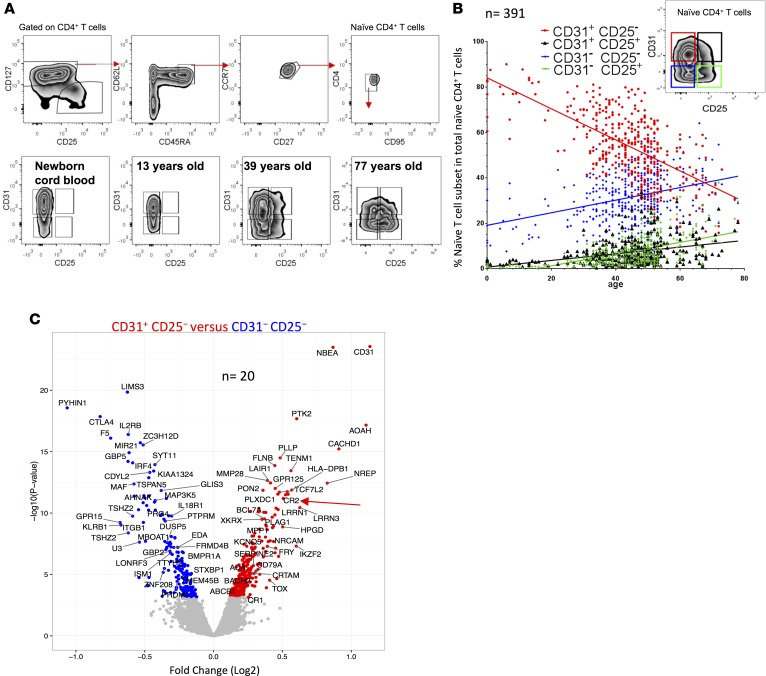
Gene expression profiling of 4 naive CD4+ T cell subsets identify age-related molecular signatures.(A) Gating strategy defining human naive CD4+ T cells; naive T cells were further stratified by CD31 and CD25. Representative examples (from n = 391; 371, 15, and 5 from cohorts 1–3, respectively; see Methods for details) of naive CD4+ T cells. (B) The proportion of naive CD4+ T cells as a function of age (color coding shown above graph). (C) Volcano plot of differences in gene expression (microarray platform) between CD31+CD25− and CD31–CD25− naive CD4+ T cells; red and blue symbols for genes with higher and lower, respectively, expression in CD31+CD25− naive CD4+ T cells (n = 20, cohort 1).